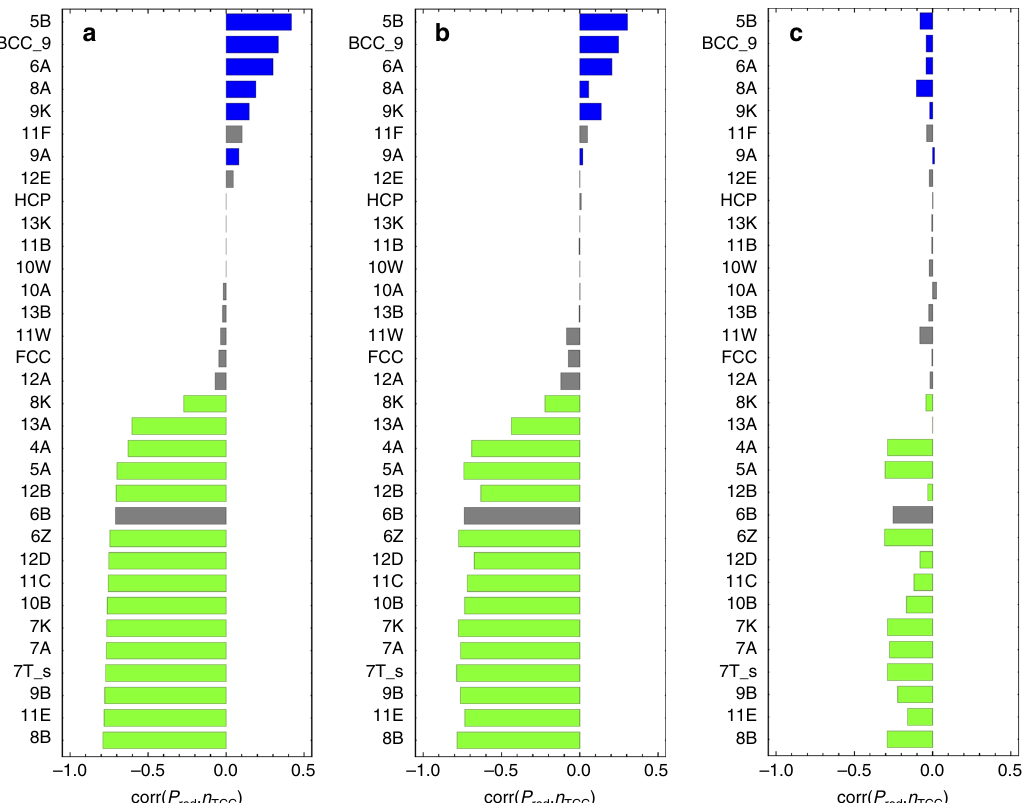
Fig. 7 Correlation between P red and TCC clusters. Correlation between the membership probability P red of a particle and the number of TCC clusters of a given type the particle is involved in, for the three investigated systems. From left to right: a hard spheres, b Wahnström, and c Kob – Andersen, at the same state points as Fig. 2. The clusters are sorted based on their correlation in the hard-sphere model. Green bars indicate clusters that consist of one or more tetrahedral subclusters, while blue bars indicate clusters that consist of one or more square pyramidal subclusters. Gray clusters contain neither (cluster 6B is a single pentagonal pyramid), or